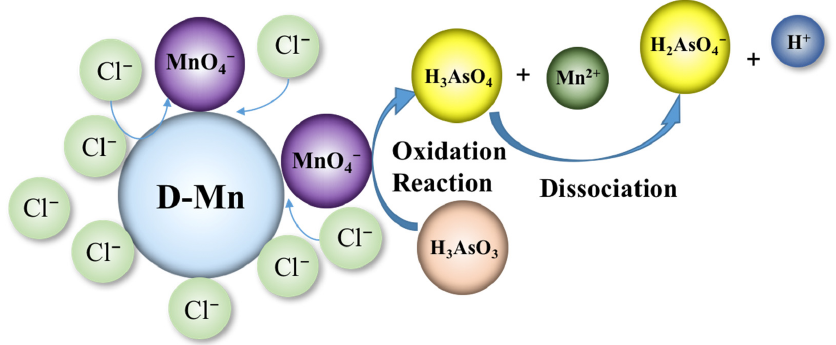
Scheme 1. Schematic representation of the effect of high Cl − ion concentration on the As adsorption of the D-Mn gel.